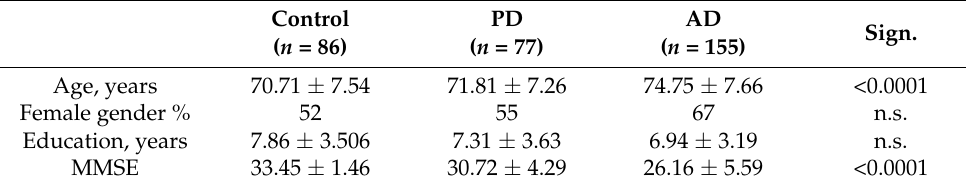
Table 1. Demographic characteristics and MMSE score for the three groups